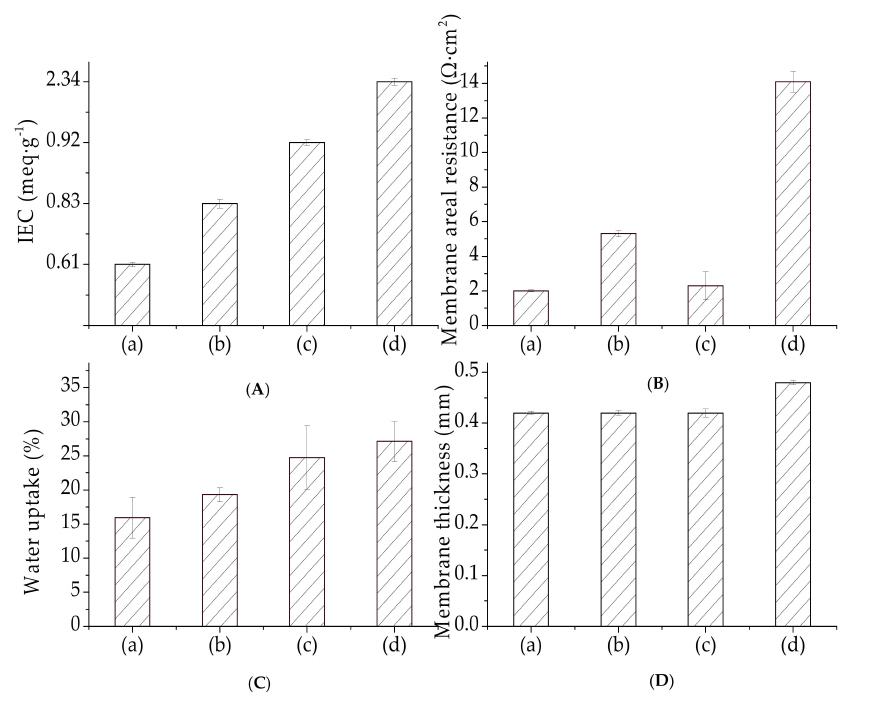
Figure 9. ( A ) IEC, ( B ) membrane resistance, ( C ) water uptake, and ( D ) membrane thickness for ( a ) PVDF / SiO 2 -4, ( b ) PVDF / SiO 2 -6, ( c ) PVDF / SiO 2 -8, and ( d ) Ionsep-HC-C